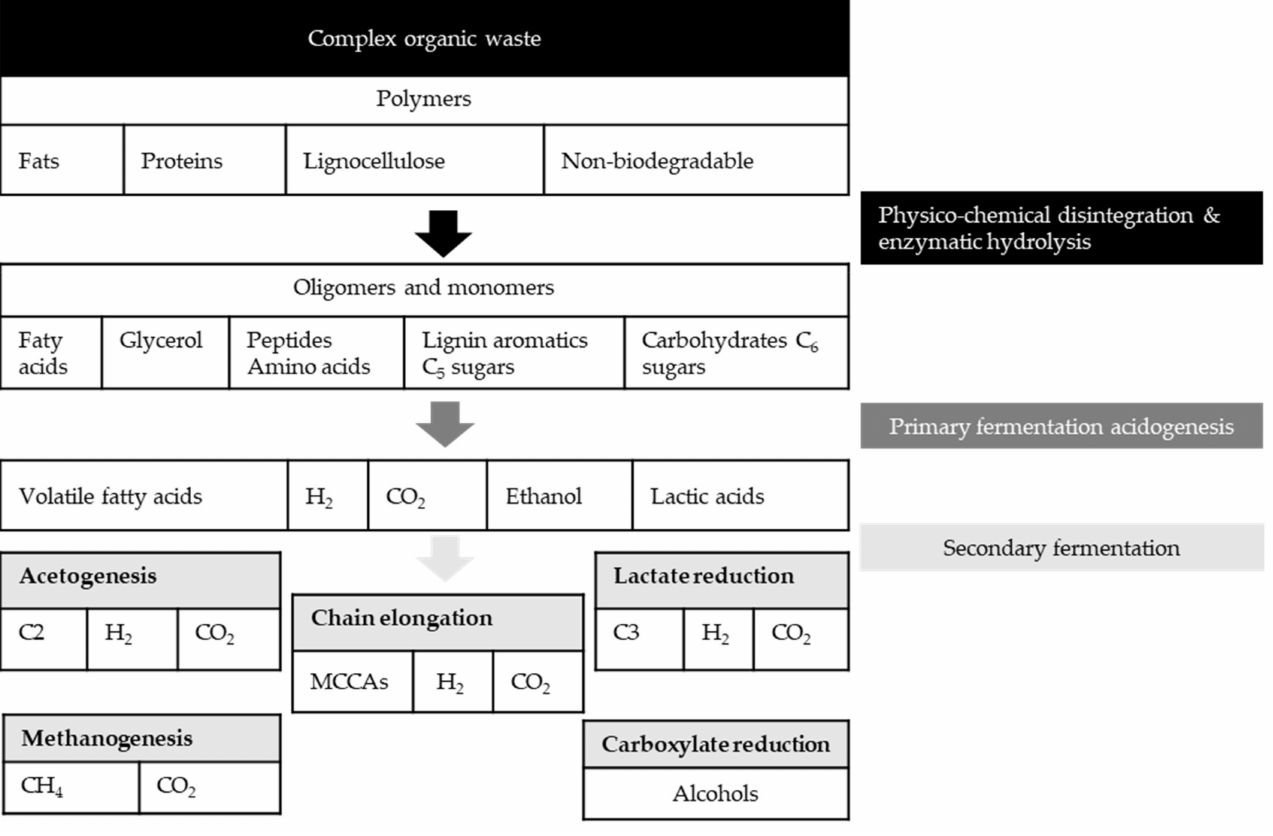
Figure 2. Possible fermentation pathways in mixed microbial culture, reused from